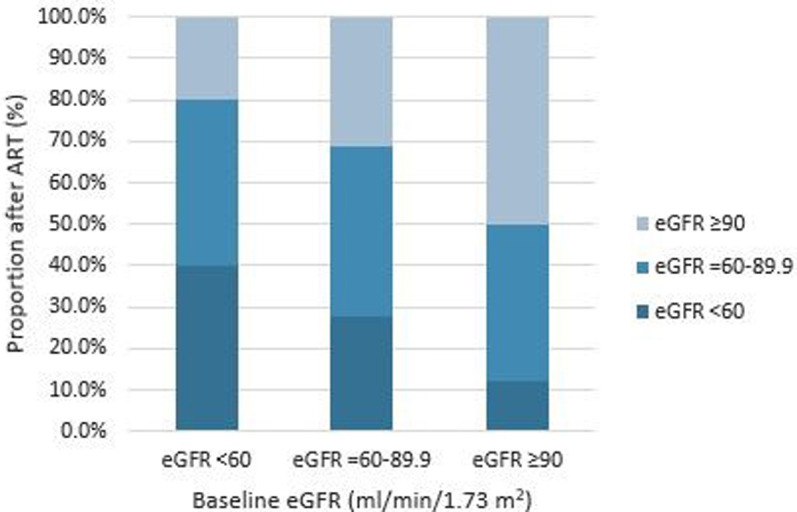
Distribution of eGFR categories of HIV-infected patients on ART stratified by baseline eGFR.